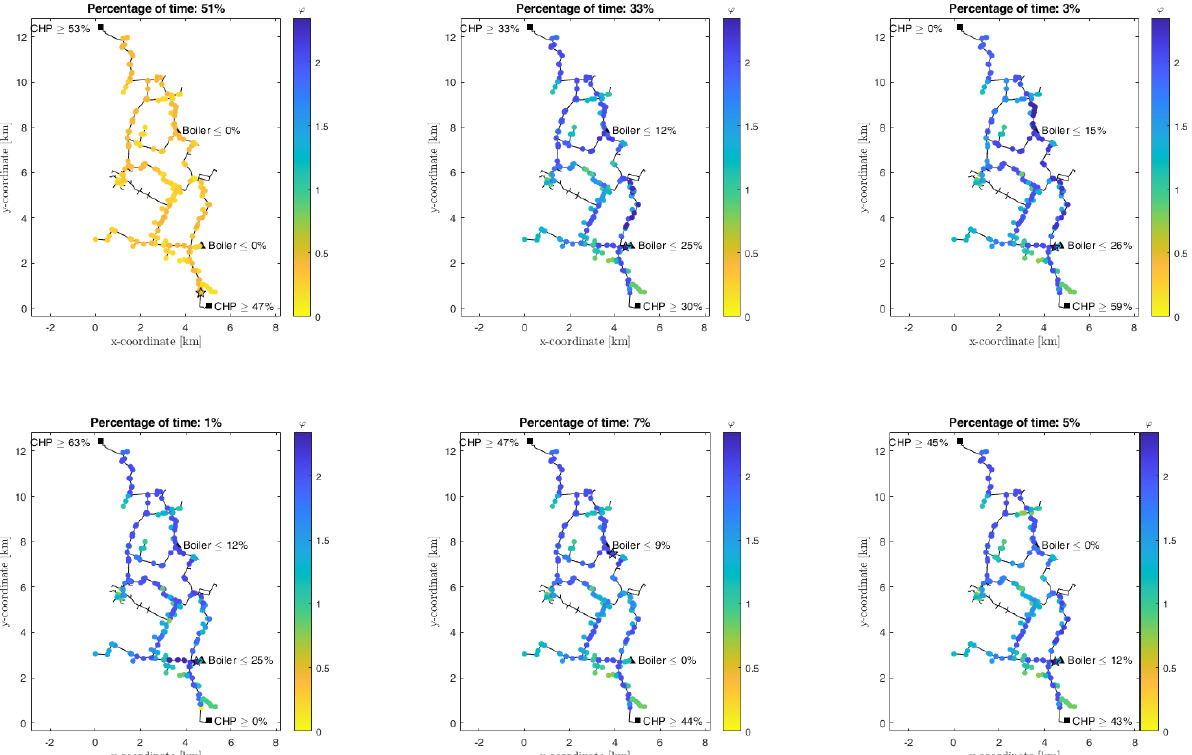
Figure 10. 𝜑 coefficient throughout the analyzed DH network with different configurations, using the mass-flow rate control strategy (the star indicates the best position for each configuration) − Con- figurations 1 to 6, mass-flow rate control strategy.